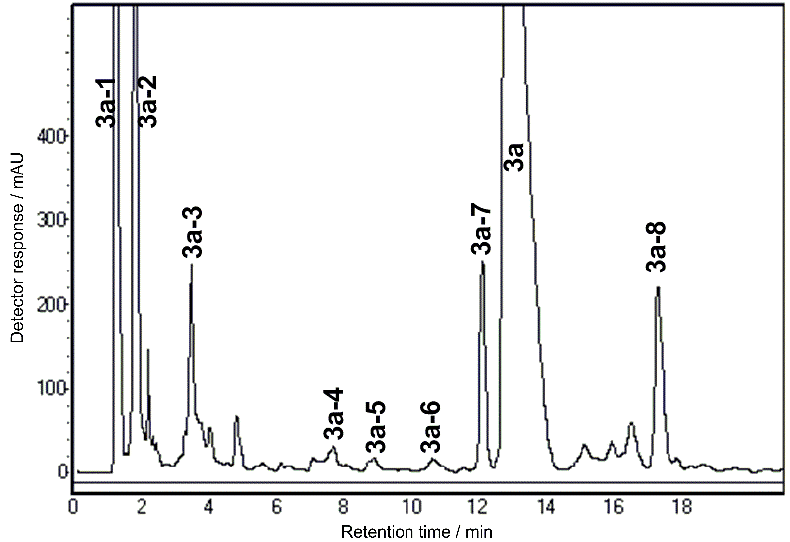
Figure 2. LC-DAD chromatogram of the macrozone 3a reaction mixture with assigned main com- ponents.